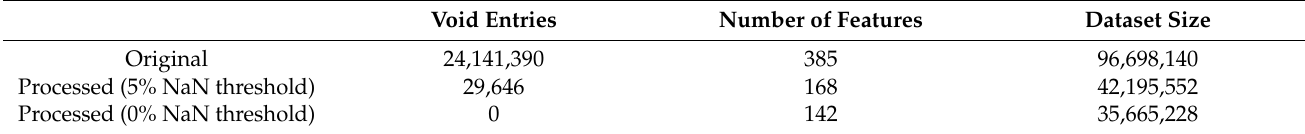
Table 3. Dataset reduction by void entry threshold.